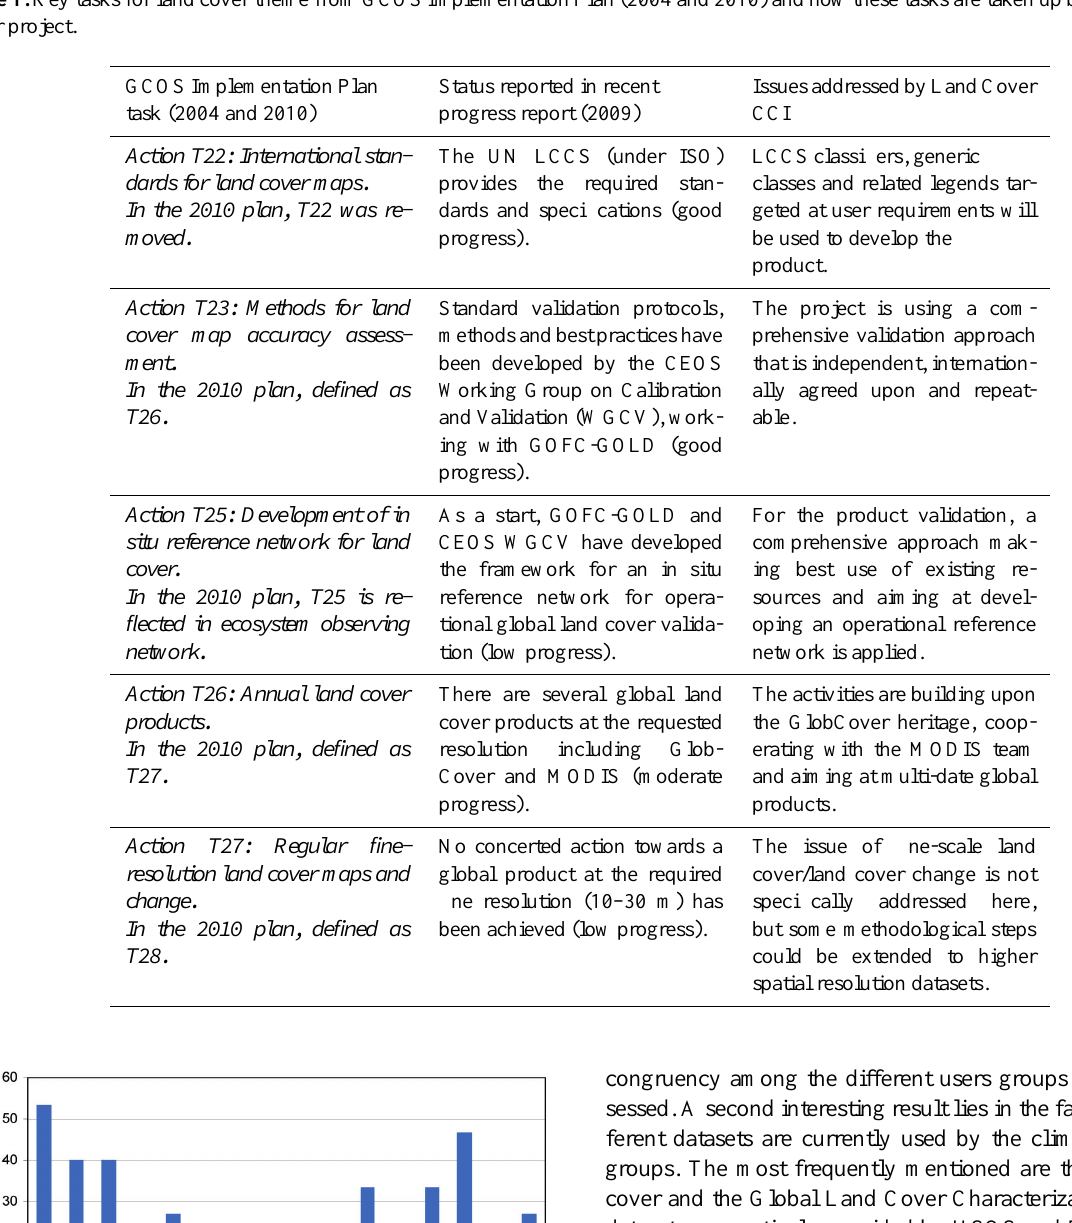
Table 1. Key tasks for land cover theme from GCOS Implementation Plan (2004 and 2010) and how these tasks are taken up by the CCI land cover project.